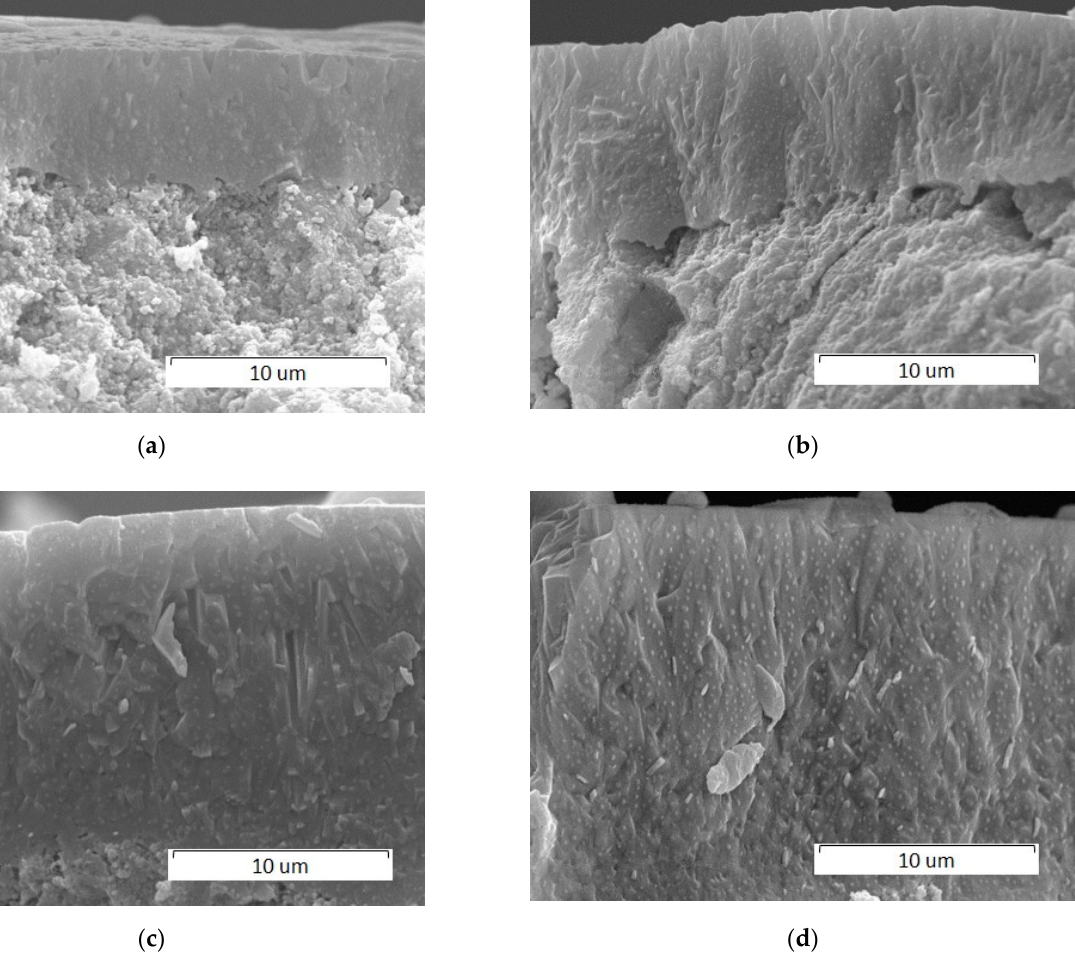
Figure 11. SEM images of cross sections of pellets treated by a 0.2 mm laser spot at a 600 mm/s scanning speed and at different laser powers: ( a ) 4 W; ( b ) 6 W; ( c ) 10 W; and ( d ) 14 W.